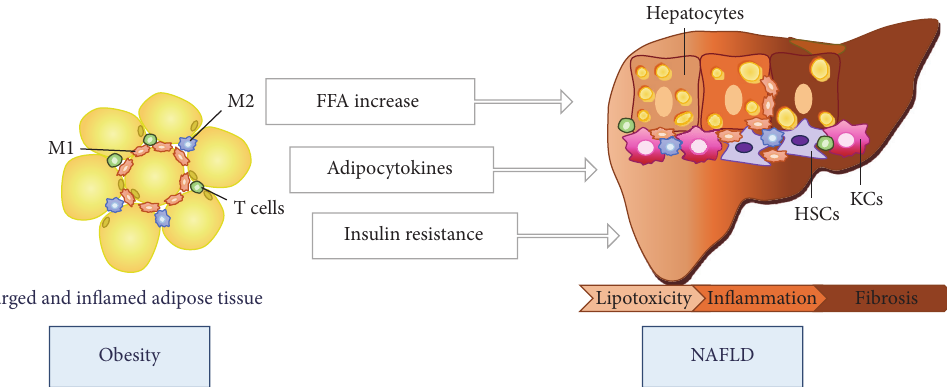
Figure 1: The crosstalk between adipose tissue macrophages and the liver cells in